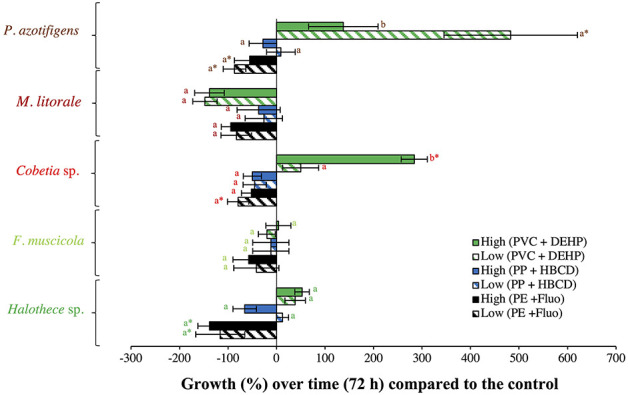
Growth responses of diazotrophs subject to MP-additive interactions (PE + fluoranthene, PP + HBCD, and PVC + DEHP) after 72 h (under relevant concentrations), compared with the control value. “Low” and “High” represent low and high concentrations of MPs (0.01 and 100 μg mL−1, respectively) and plastic additive (0.3 and 300 μg L−1, respectively). Values are the mean, and the error bar is the standard error between the replicates (n = 3). Letters indicate pairwise analysis among the variables (i.e., concentration) inside each strain (see the different colors), and asterisks (*) indicate pairwise significant differences between variables and the control (p < 0.05), using a post-hoc test (Wilcoxon) after Kruskal-Wallis over the whole dataset.